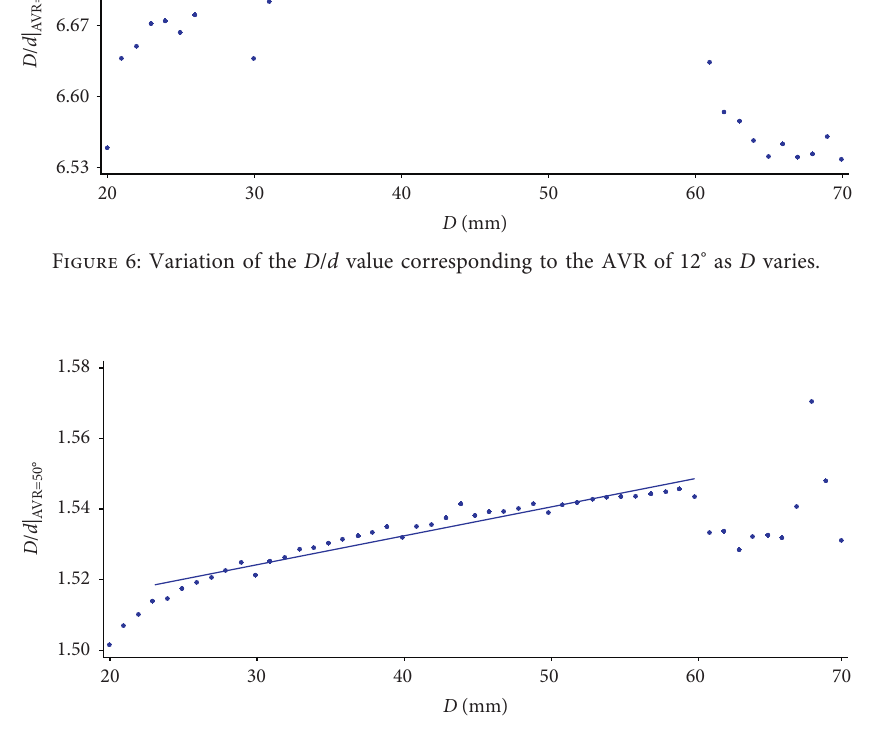
Figure 7: Variation of the D / d value corresponding to the AVR of 50 ° as D